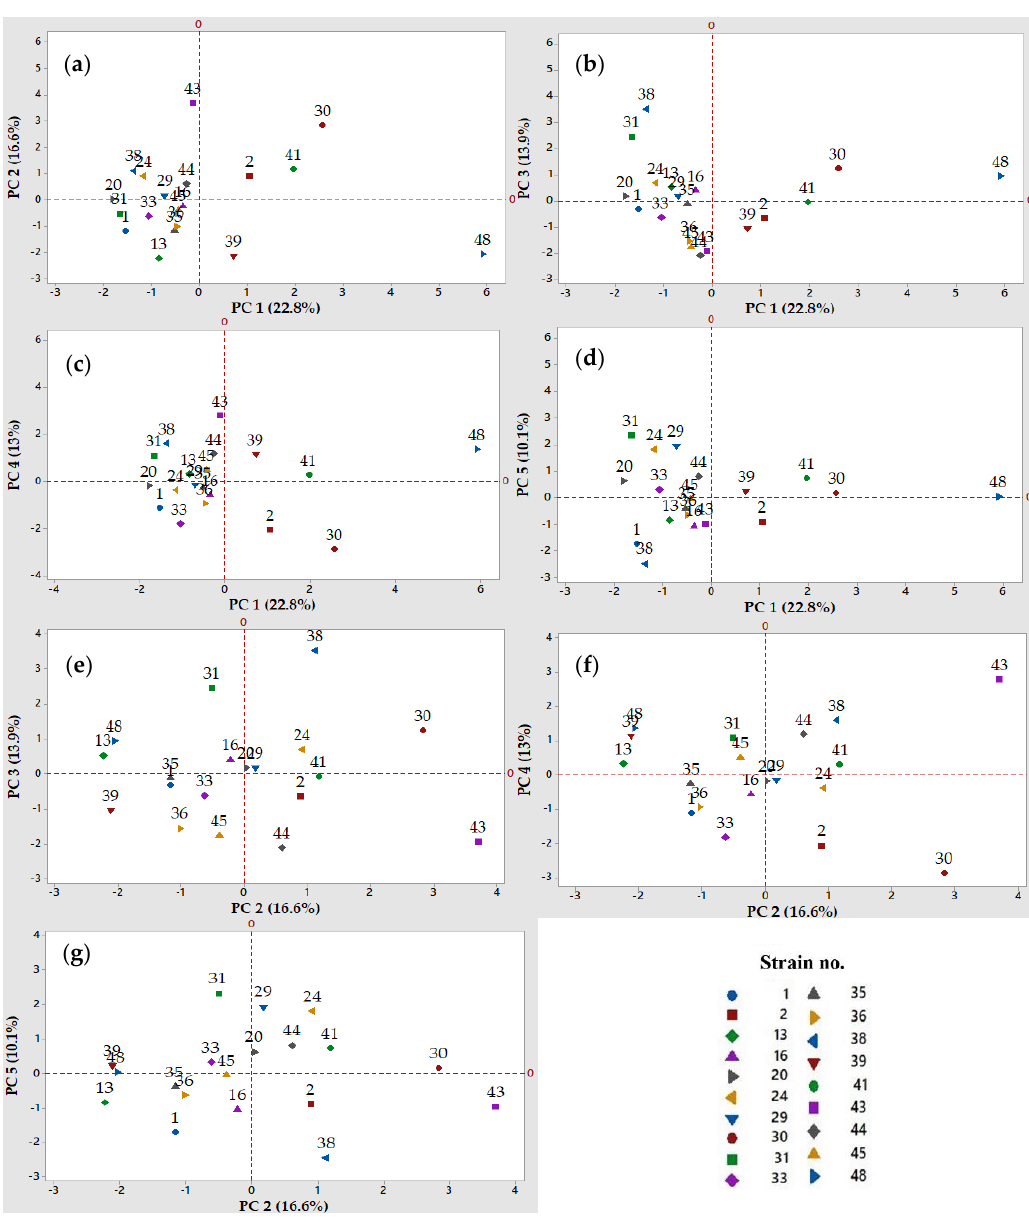
Figure 3. Two-dimensional score plots of the Principal Component Analysis (PCA). Projection of the observations (LAB strains) into the principal component (PC) 1 to 5 (cumulative percent variability in parentheses), for the independent variables depicted in Figure 2: ( a ) PC 1 and PC 2 (39.4%); ( b ) PC 1 and PC 3 (36.7%); ( c ) PC 1 and PC 4 (35.8%); ( d ) PC 1 and PC 5 (32.9%); ( e ) PC 2 and PC 3 (30.5%); ( f ) PC 2 and PC 4 (29.4%); and ( g ) PC 2 and PC 5 (26.7%). The numbers in the plots refer to the identification of LAB strains.